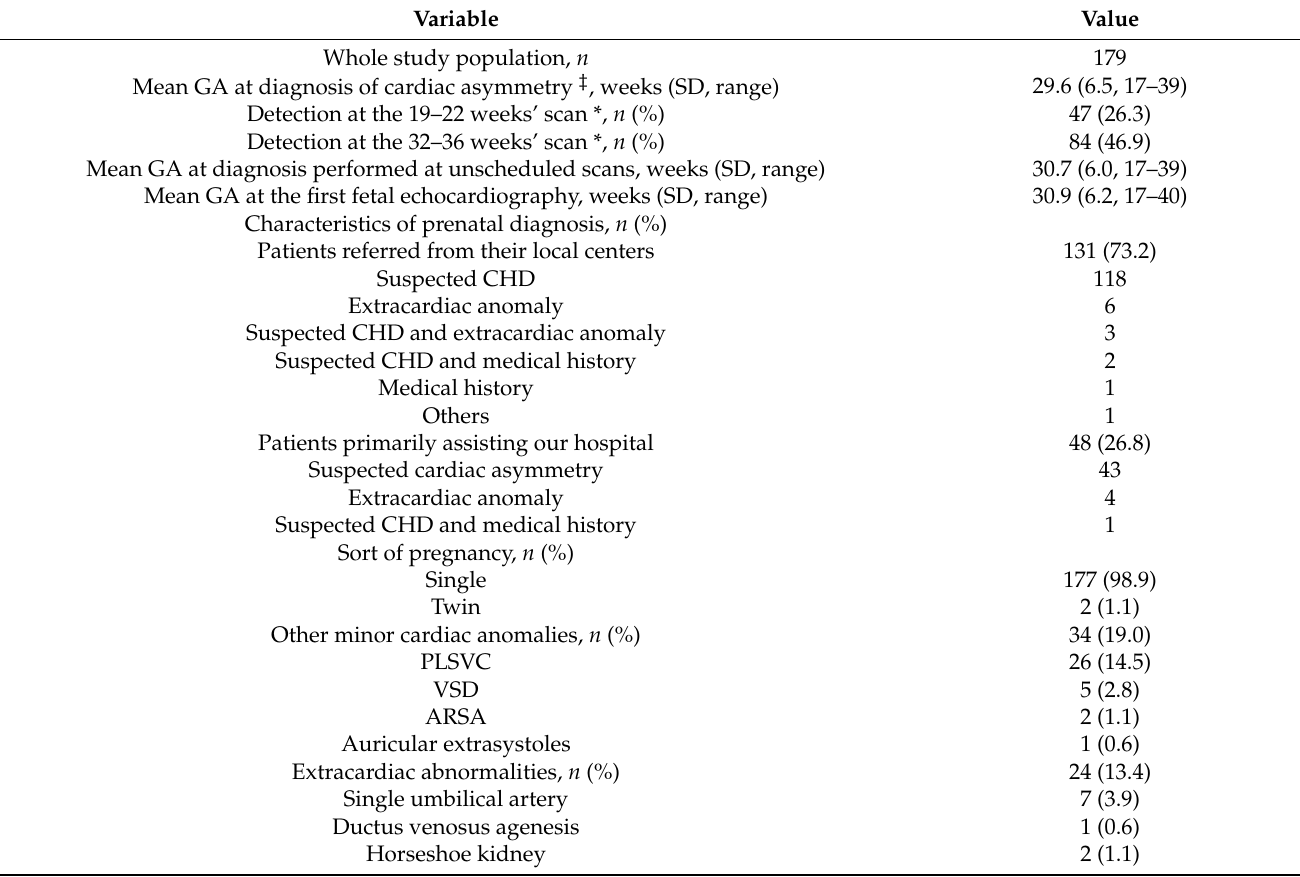
Table 2. Prenatal characteristics of the whole study population. Variable Value Whole study population, n 179 Mean GA at diagnosis of cardiac asymmetry ‡ , weeks (SD,